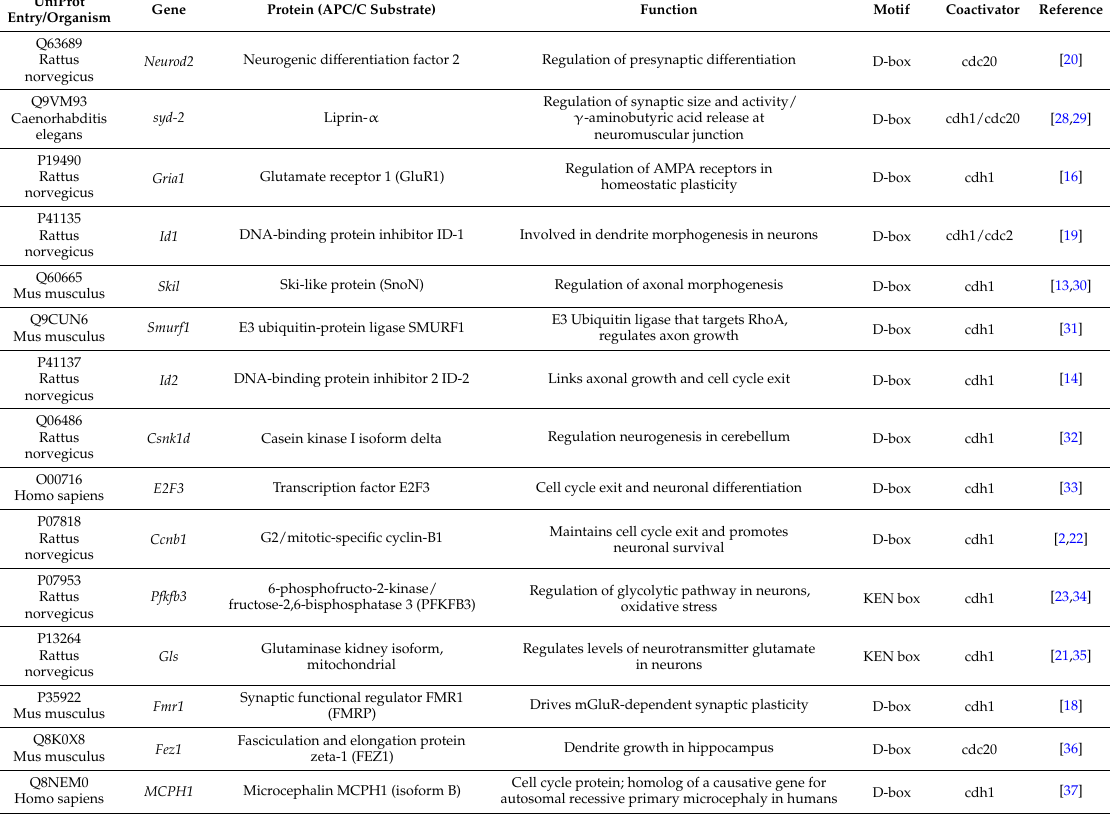
Table 1. A list of Anaphase Promoting Complex/Cyclosome (APC/C) substrates that are directly involved in major functions in the central nervous system. APC/C-Cdh1 and APC/C-Cdc20 regulate neurogenesis, axon and dendrite growth, synaptic differentiation, synaptic regulation, cell cycle exit, neuronal survival and glucose metabolism in